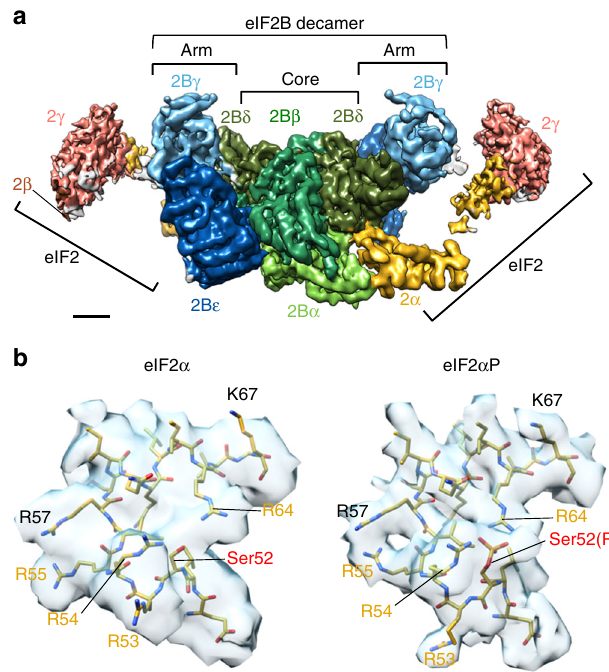
Fig. 5 Non-phosphorylated eIF2/eIF2B complex is almost identical to eIF2 α P/eIF2B. a Overview of eIF2/eIF2B structure map (after local amplitude scaling (Locscale)). Orientation and surface coloured as in Fig. 1a. Scale bar is 20 Å. b Model fi tting to electron cryomicroscopy (cyoEM) maps around Ser52 in eIF2/eIF2B (left) and eIF2 α P/eIF2B (right) complexes, indicating some minor differences between